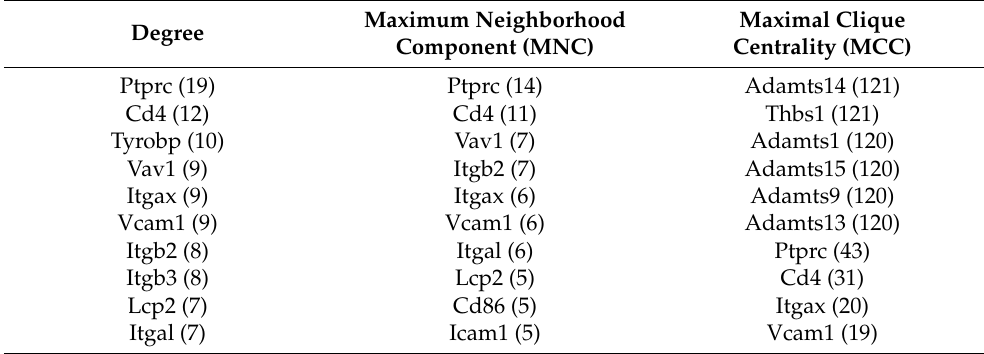
Table 1. Top 10 Hub Genes (Score) in STRING Network Analysis by